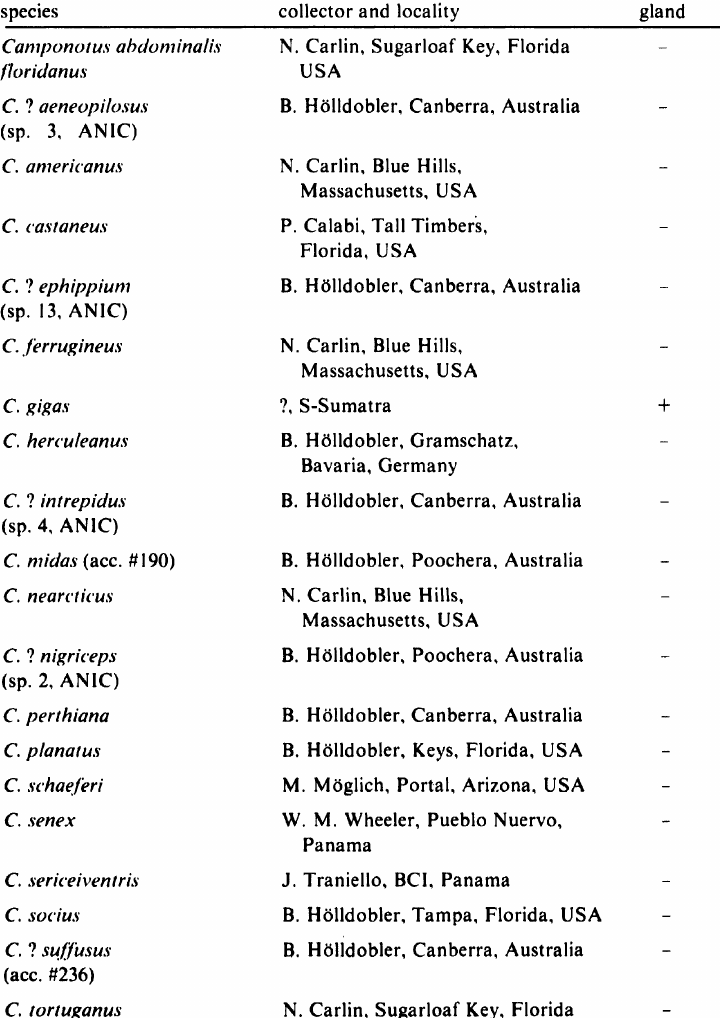
Table 2. An external survey of the presence (+) or absence (-) of features that indicate a metapleural gland in the genera Camponotus, Dendromyrmex, and Polyrhachis. Further information concerning species identification see Table